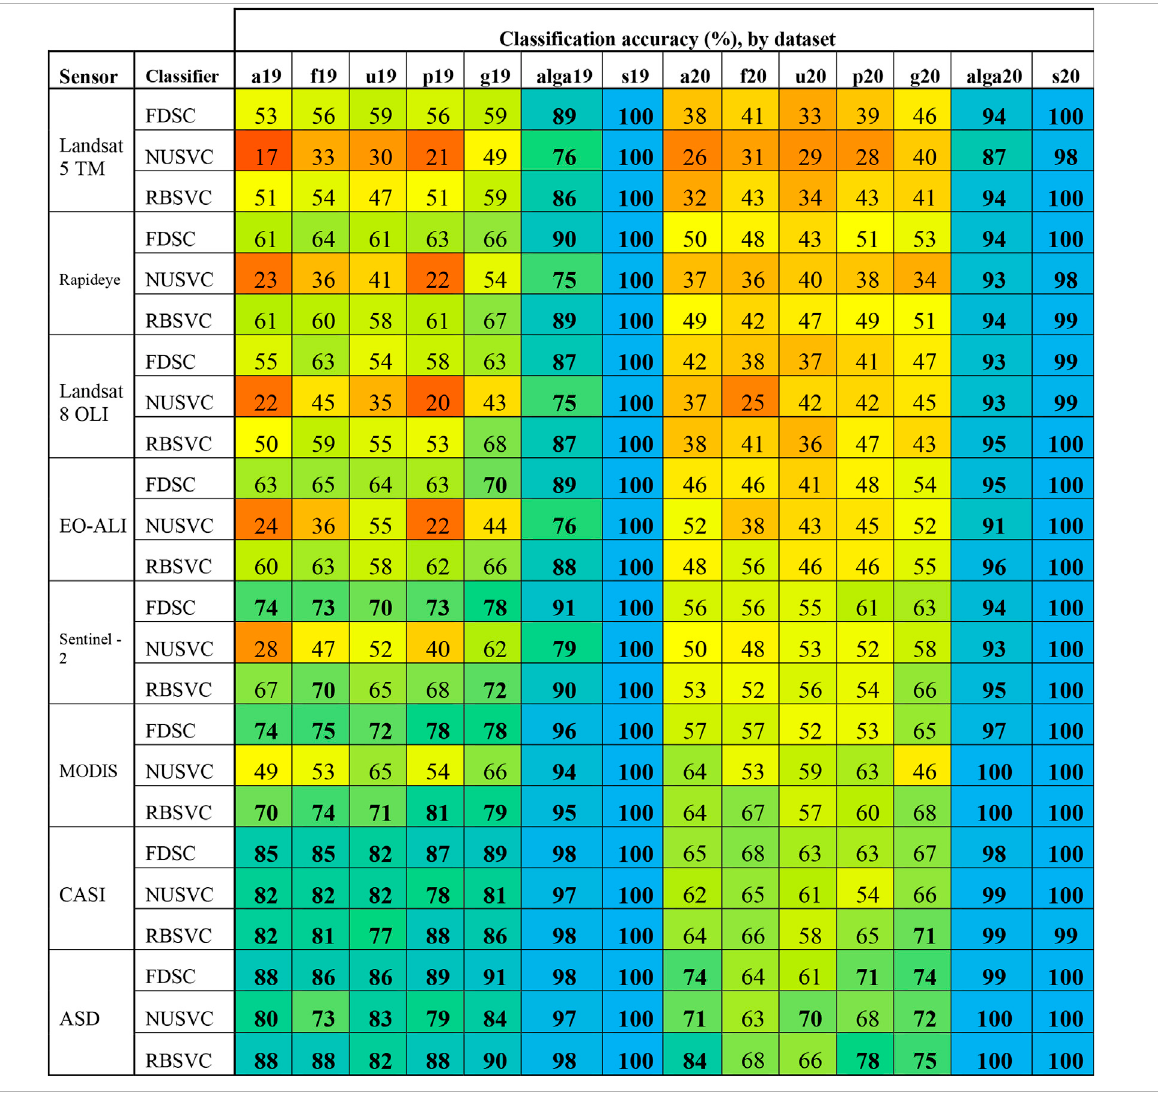
TABLE 3| Classi fi cationaccuracyoftheFSDC, NUSVC,andRBSVCclassi fi ersforeach groupingandyearfortheoriginal(ASD)andallresampledspectra.Accuracyvalues have been colour coded for rapid interpretation (gradient: red (cid:1) 0, yellow (cid:1) 0.5, blue (cid:1) 1). All values above 0.7 have been bolded for easy identi fi cation. Datasets are described in Supplementary Table